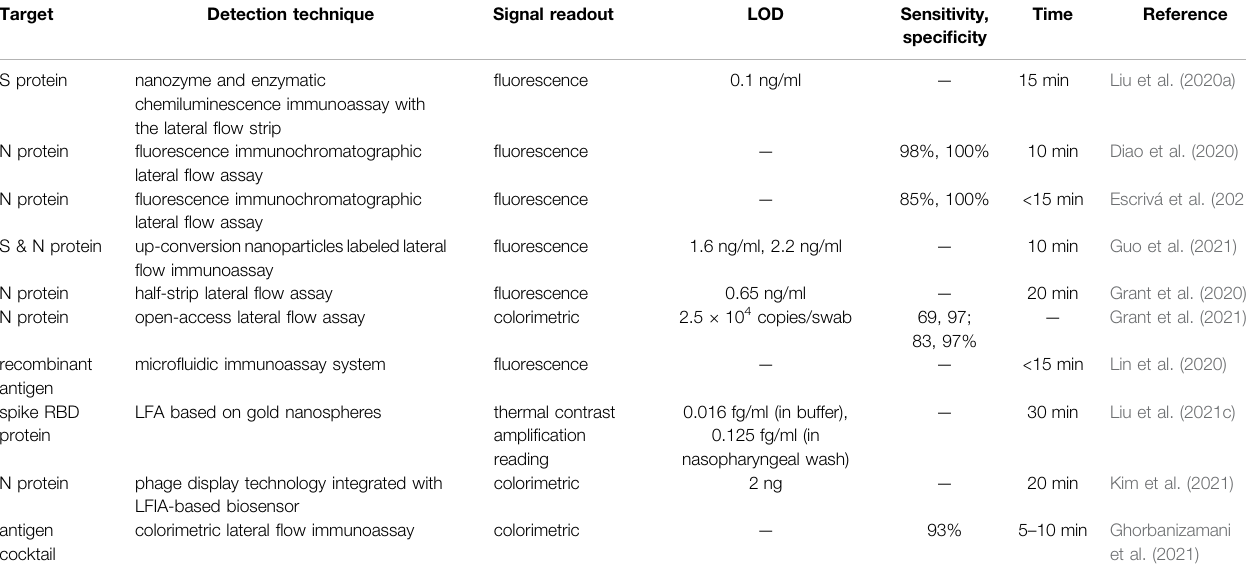
TABLE 3 | Antigen-based lateral fl ow assay of